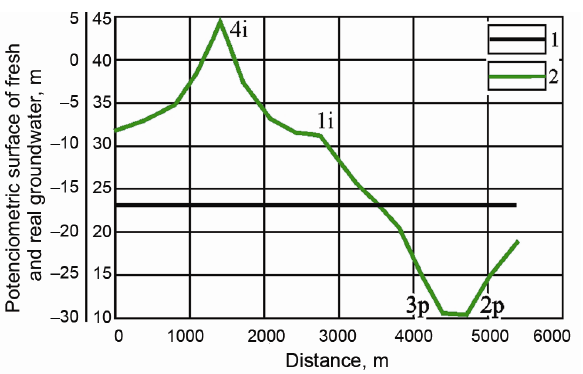
Fig. 5. Piezometric surface of groundwater in the Viešvilė aqui- fer in the direction of section A–A: 1 – initial; 2 – before the stoppage of the plant in 2007